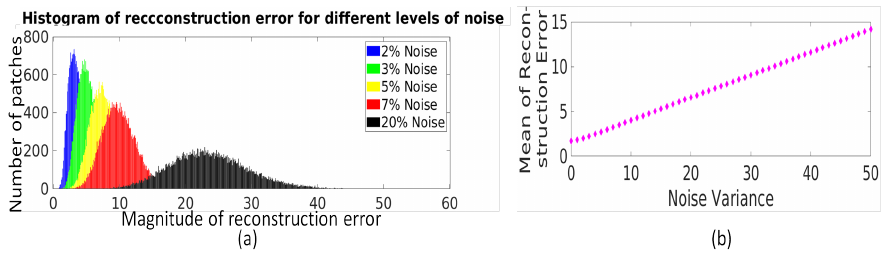
Figure 3. ( a ) Illustration of the relation between distribution of LRA-based reconstruction error values ( e ) of an ensemble of image patches and strength of noise, i.e., noise variance. ( b ) Illustration of the relation between mean of reconstruction error values with strength of noise, i.e., noise